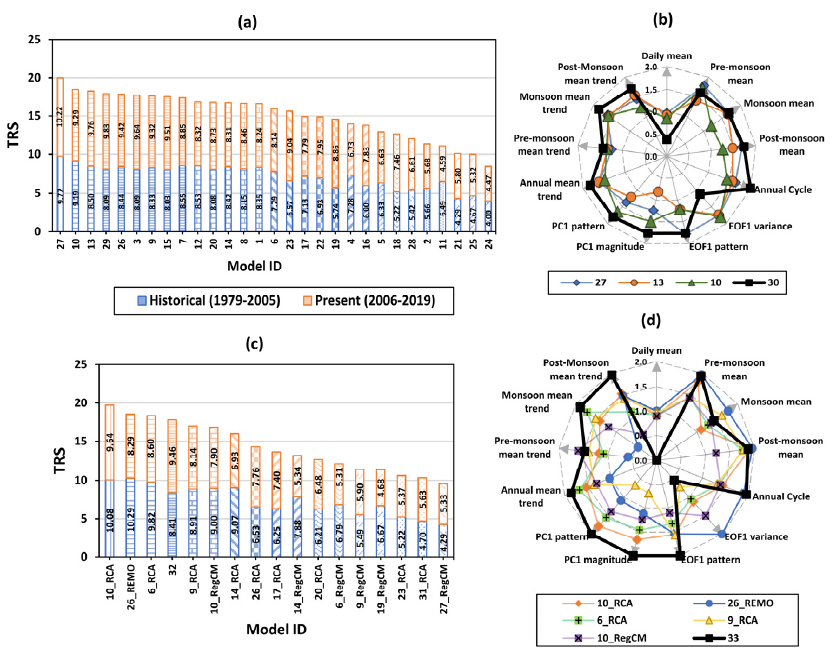
Figure 8. Summary of climate model’s skill over ocean part of South Asian domain for the historical and present time slice. ( a ) Computed Total Relative Score (TRS) of CMIP5 GCMs. ( b ) Relative Score of best-performing CMIP5 GCMs for different climate variable scales. ( c ) As in ( a ), but for CORDEX RCMs. ( d ) As in ( b ), but for CORDEX RCMs.